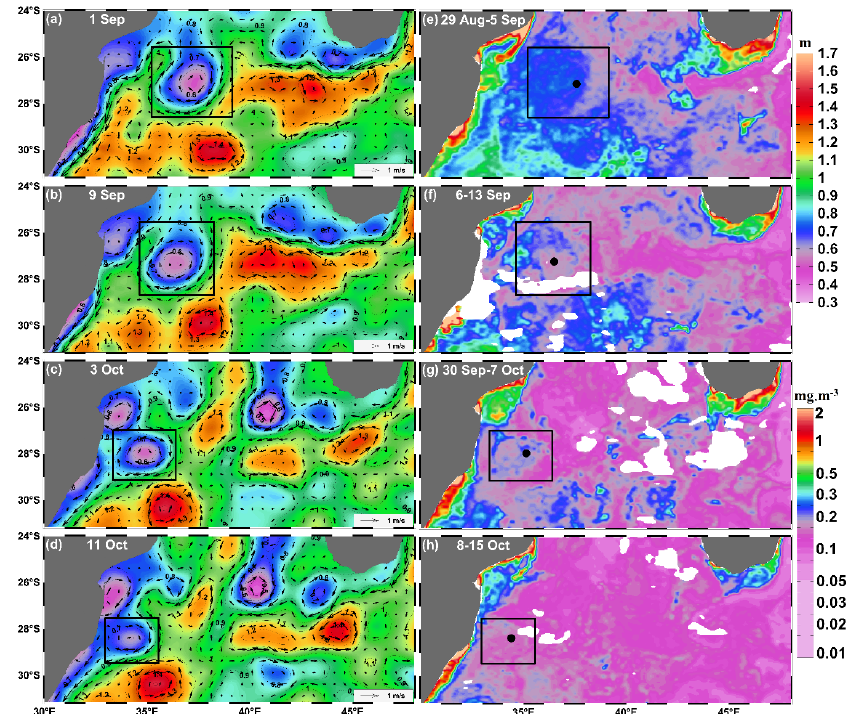
Figure 7. Fractional contribution of ( a – d ) micro-, ( e – h ) nano-, and ( i – l ) picophytoplankton to MODIS Aqua chlorophyll a for 28 July to 28 August 2013 over the Mozambique Basin. Black boxes highlight the location of the cyclonic eddy and black dots indicate the centre of the eddy. White areas indicate missing data due to cloud cover.